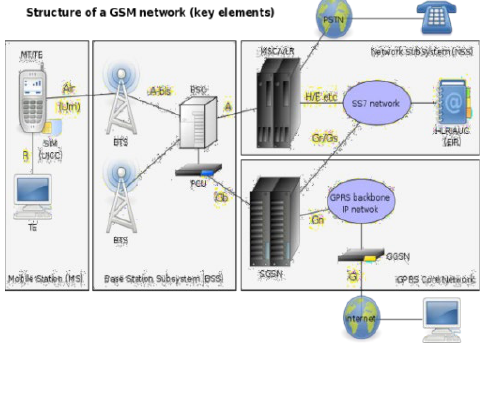
Figure 7. GSM network Topology [20]